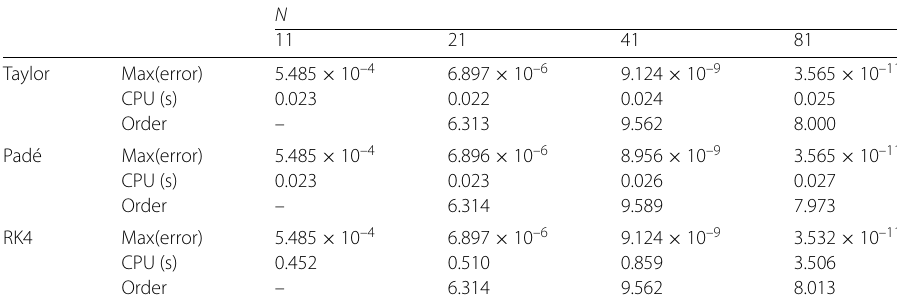
Table 3 Numerical results of one-dimensional parabolic problem at t = 0.1 for case 2 of Example 1